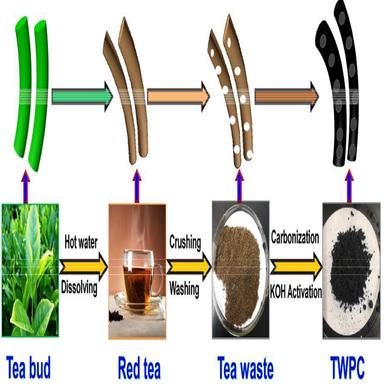
Synthetic pathway of the biomass TWPC derived from tea waste through a facile method of combined carbonization and activation processes.